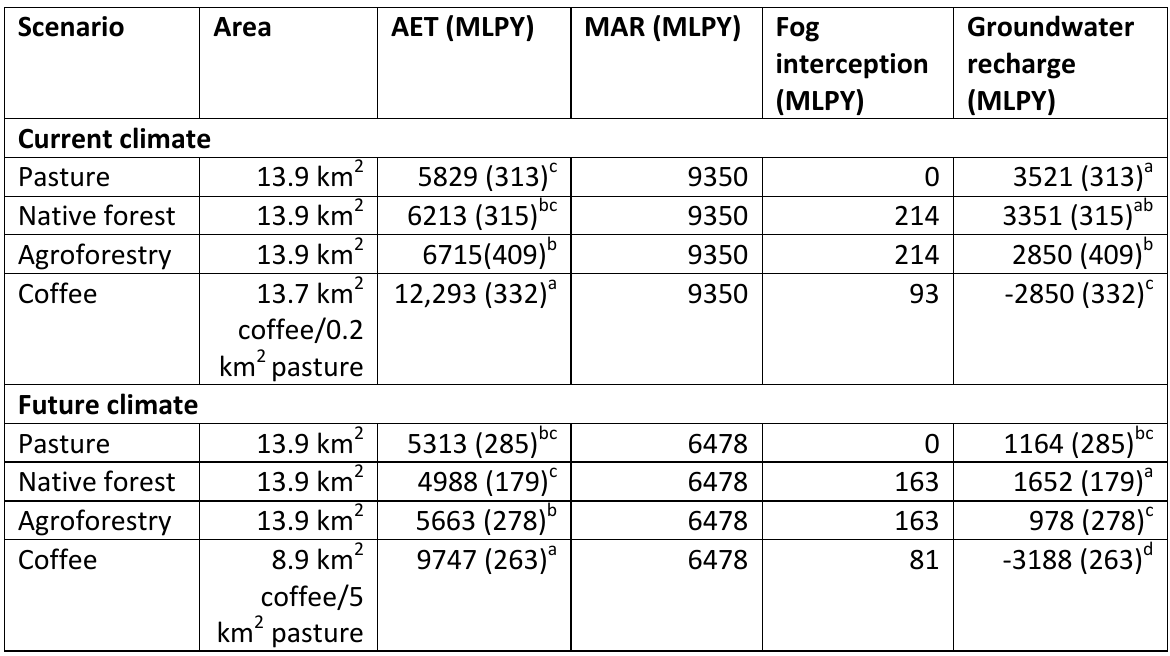
Table A1.12. Mean Annual Rainfall (MAR), fog interception, evapotranspiration, and groundwater recharge in the study area in millions of liters per year (MLPY). Letters indicate significant differences in AET and groundwater recharge among land uses within each climate